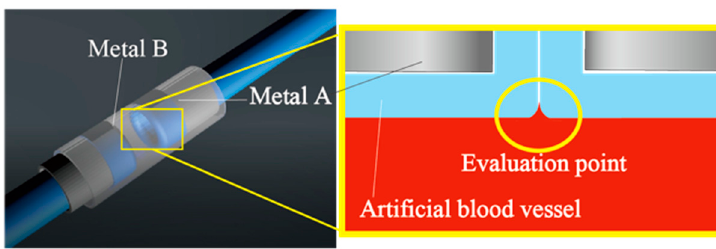
Figure 3. Joint area inside the connector. A small ditch is formed at the interface, where blood coagulation might be promoted.